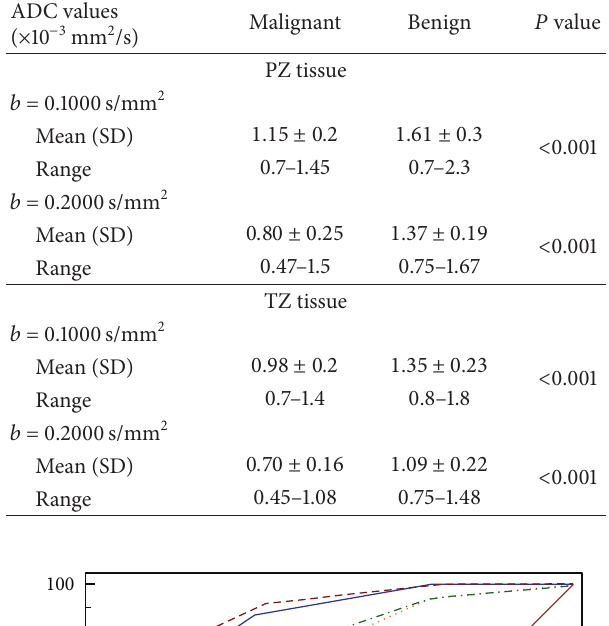
Table 1: The ADC values of malignant and benign peripheral and transitional tissue at 𝑏 = 0–1.000 and 0–2.000 s/mm 2 .